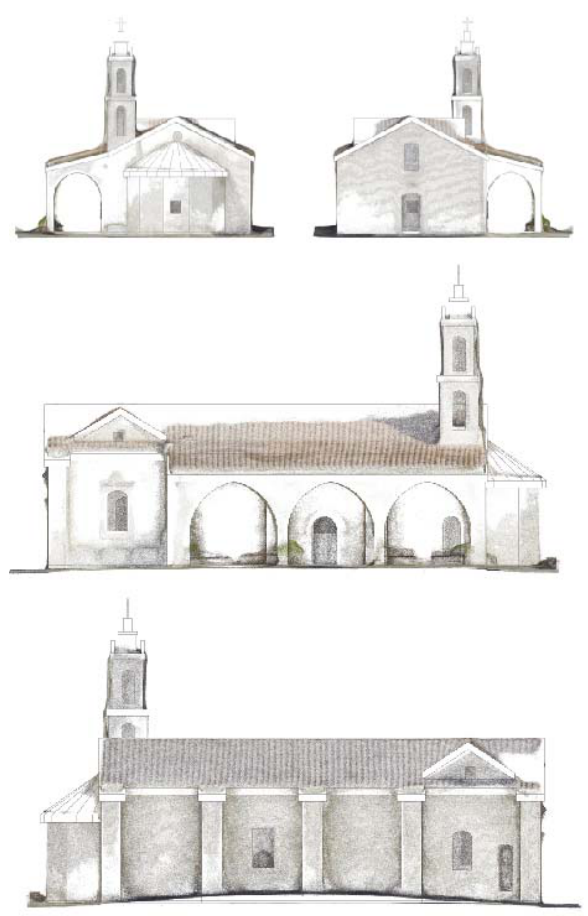
Figure 11. Drawings of elevations of the Foinikaria